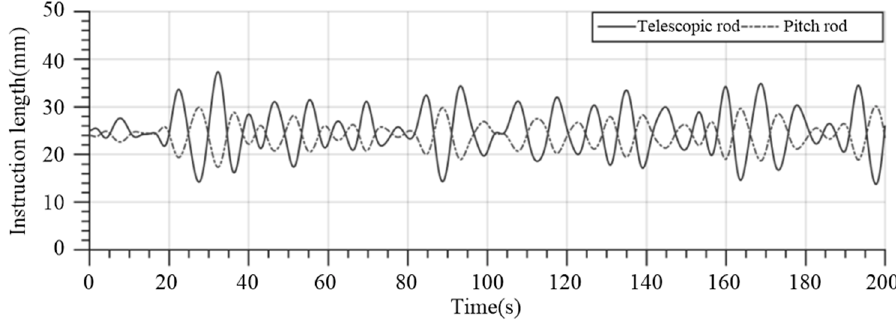
Figure 19. Command length of gangway telescopic rod and pitch rod when the ship is equipped with controllable passive anti-rolling tank.